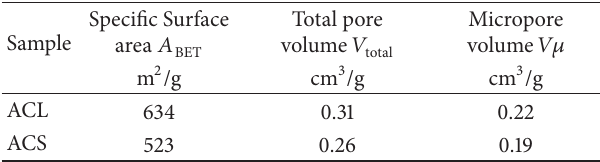
Table 1: The surface properties of prepared activated carbon sam- ples obtained from low-temperature nitrogen adsorption isotherm